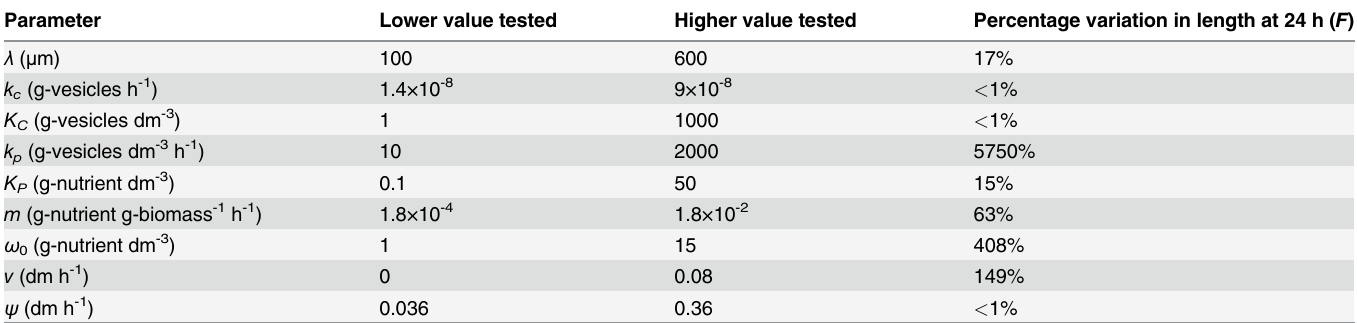
Table 2. Sensitivity to the model parameters of the fi nal hyphal length reached at 24 h by Rhizopus oligosporus .